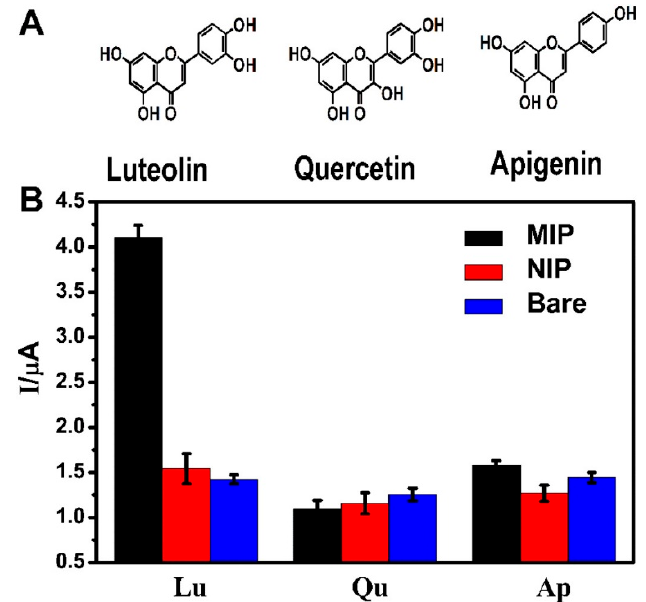
Figure 14. ( A ) The chemical structural formulas of luteolin and two similar structural flavonoids, from left to right: luteolin (Lu), quercetin (Qu) and apigenin (Ap). ( B ) Comparison of the DPV responses of luteolin and the structural analogs in 0.1 M PBS (pH 6.0) at MIP (black), NIP (red), and bare (blue) electrode, respectively. Luteolin concentration: 5.0 × 10 − 6 M, quercetin and apigenin concentration: 5.0 × 10 − 5 M. Incubation time: 3 min. Reprinted from ref. [121] with permission of Elsevier.